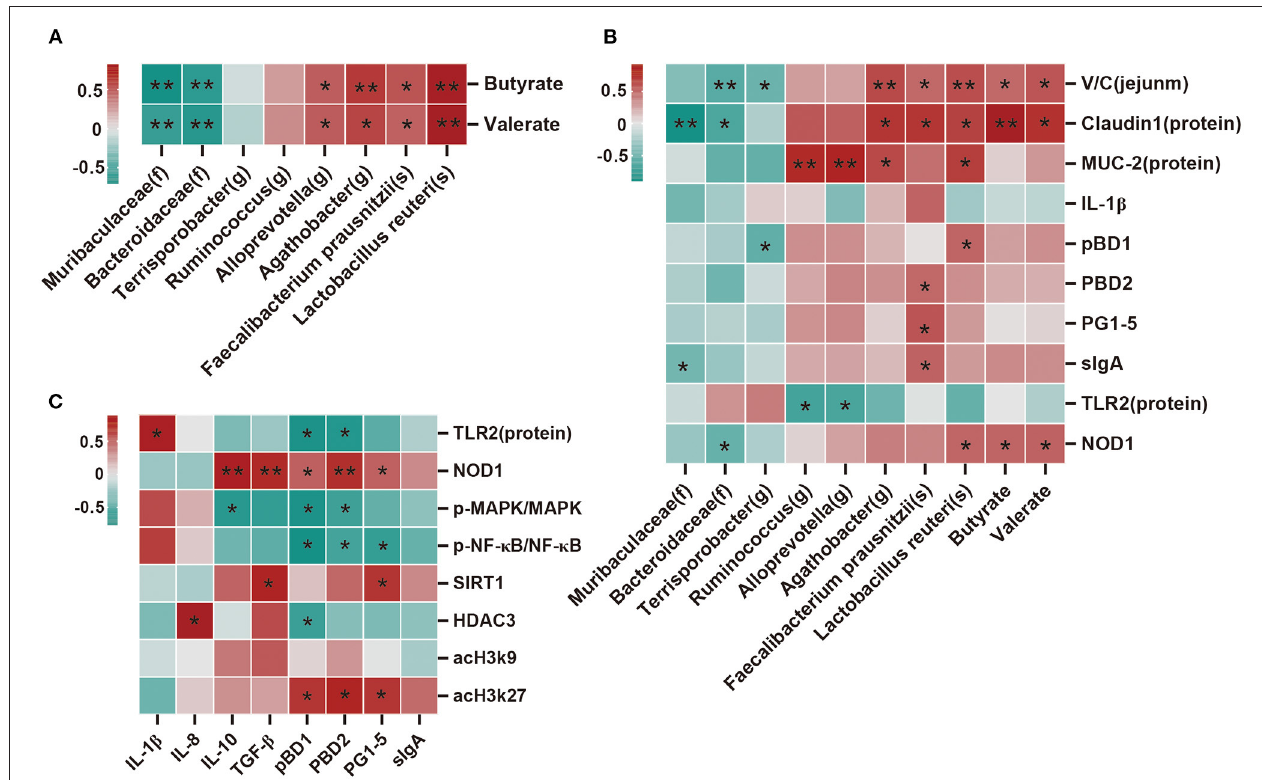
FIGURE 7 | Correlation analysis of the dominant bacteria, SCFAs, barrier function factor, and immune factor. (A) Correlation analysis between microbial species and SCFAs. (B) Correlation analysis between microbial species, SCFAs, and measured parameters. (C) Correlation analysis between the immune index and immunomodulatory factor. Except for microbial species, SCFAs, and V/C (ratio of villi height to crypt depth), all other indicators belong to the ileum. There are indicators for mRNA expression and protein expression data, and protein expression data was selected for analysis. Protein expression data n = 3, other data n = 6. Red represents positive correlation and green represents negative correlation (* p < 0.05, ** p < 0.01).